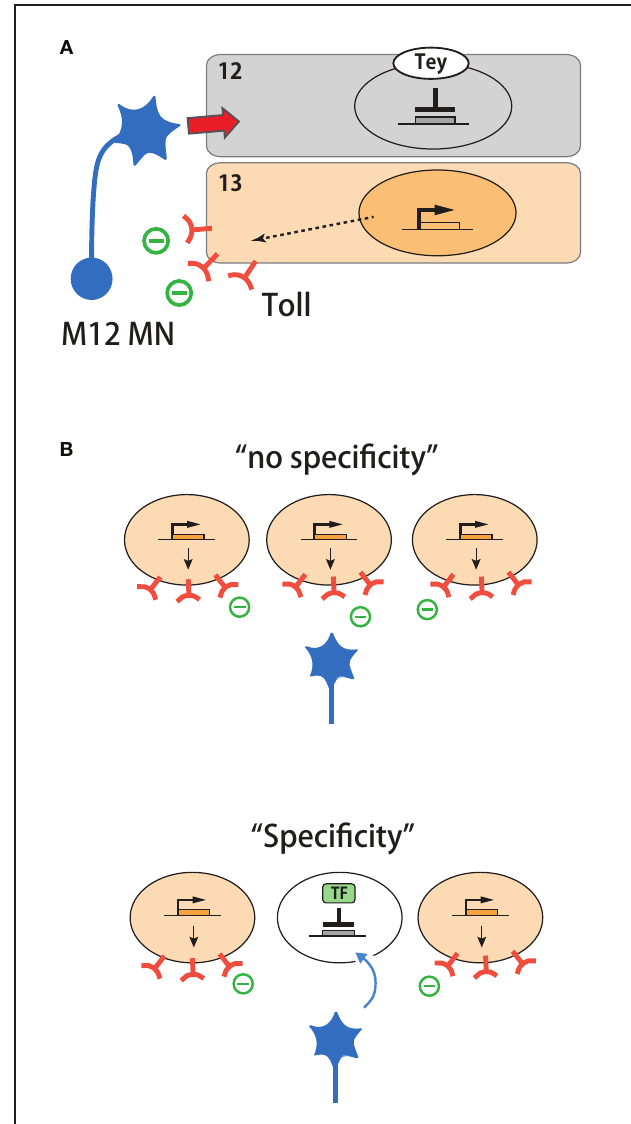
FIGURE 3 | Transcriptional regulation of target specificity by repression of inhibitory cues. (A) Tey represses expression of Toll in M12 and thereby determines target specificity. (B) A model in which target specificity can be generated in a group of equivalent targets by transcriptional repression of a repulsive